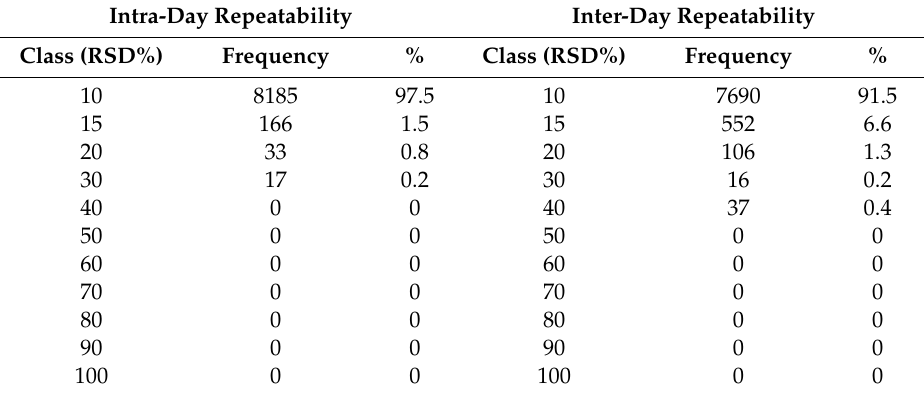
Table 1. Frequency of each relative standard deviation percentage (RSD%) class obtained for intra-day and inter-day repeatability evaluated on the quality control (QC) sample.